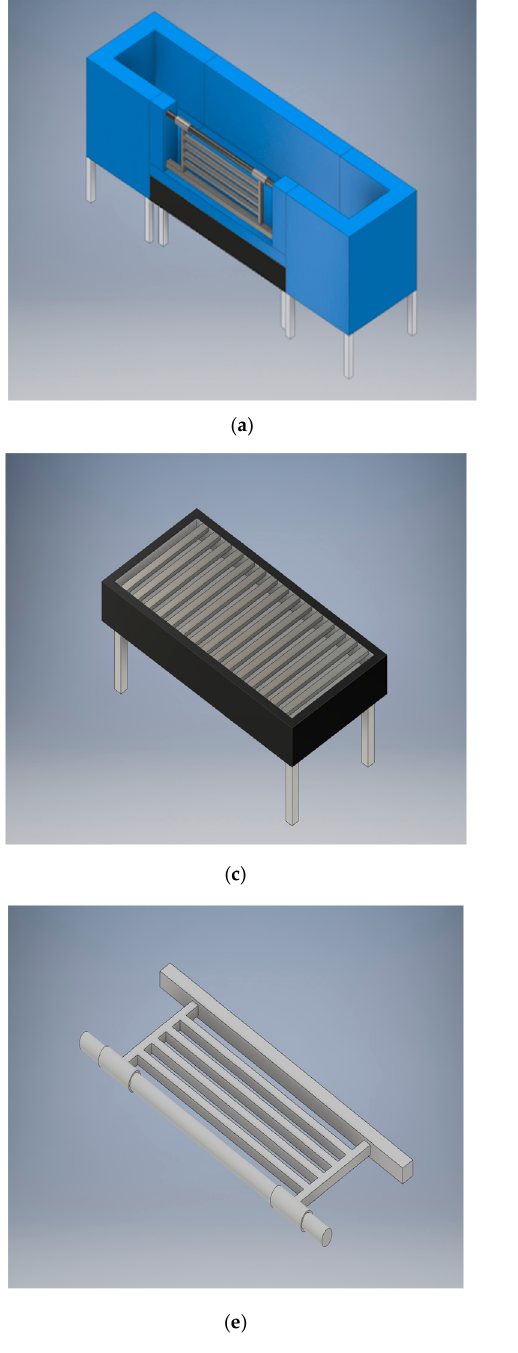
Figure 4. Repurposed parts of concept 3. ( a ) Crib design. ( b ) Chair design. ( c ) Grill design. ( d ) Safety door design. ( e ) Drying rack design. ( f ) Pull-up bar design.